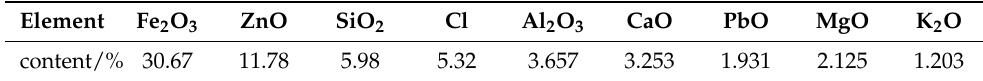
Table 1. Chemical multielement analysis of zinc-bearing dust sludge (%).